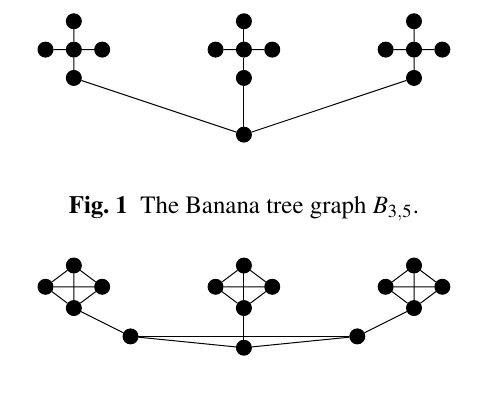
Fig. 2 The line graph of Banana tree graph B 3 , 5 .